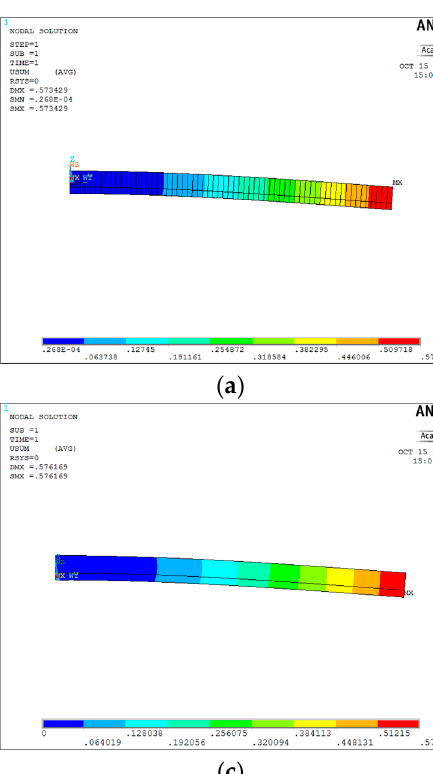
Figure 3. ( a ) Deformed shape of the PZT–Steel composite beam; ( b ) Close up view.